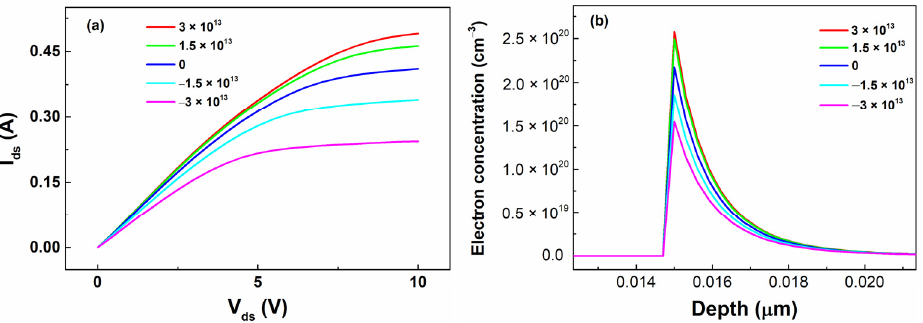
Figure 3. ( a ) The output characteristics and ( b ) carrier concentration distributions of the HEMT with different surface charge density at V g =0 V.